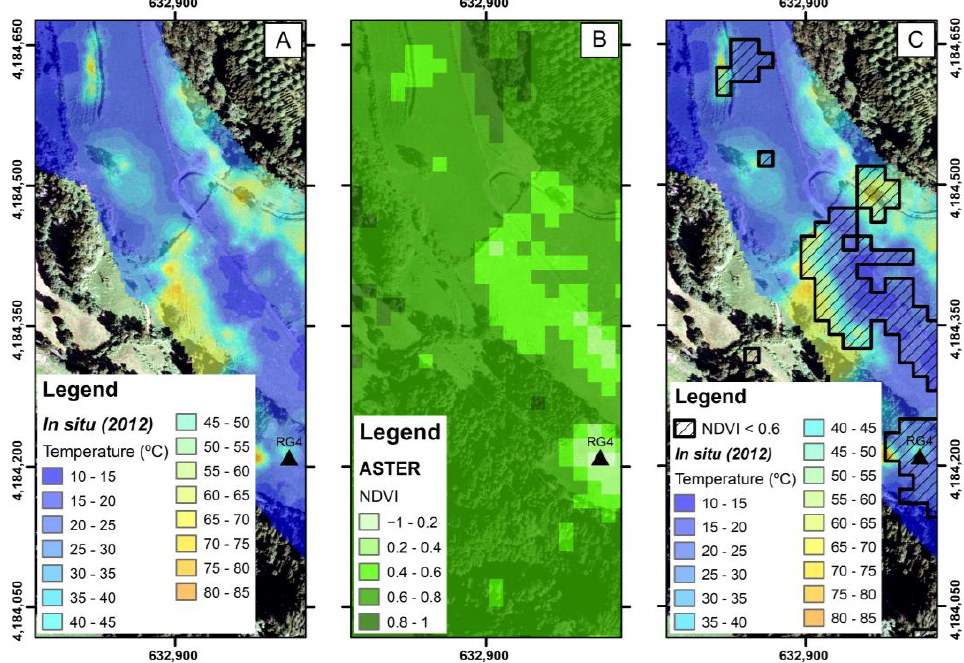
Figure 8. Overlay of the lowest NDVI map values (April 2012) with the respective in situ soil temperatures map (January 2012). ( A ) In situ soil temperature; ( B ) the ASTER NDVI values; and ( C ) a comparison of the soil temperature and lowest values of the NDVI.